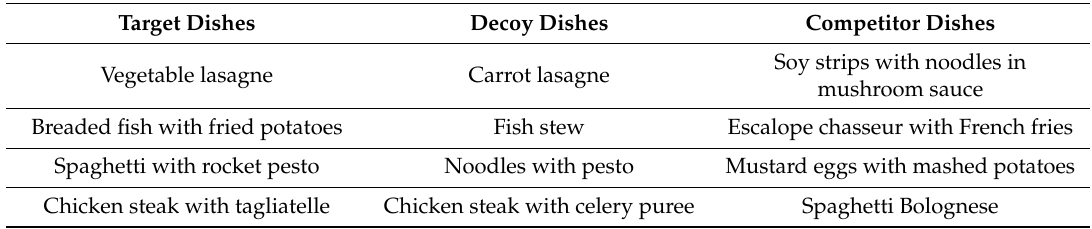
Table 5. Target, Decoy and Competitor